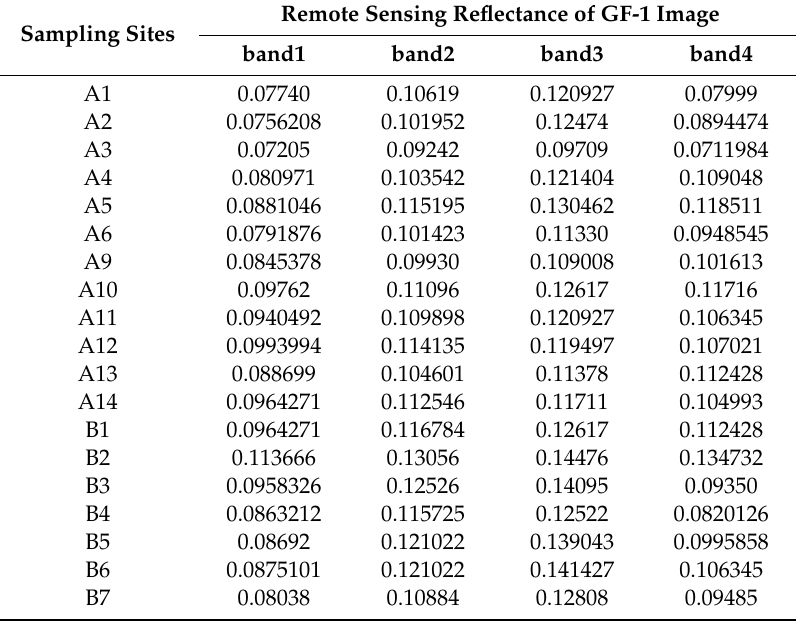
Table A2. The remote sensing reflectance of GF-1 image corresponding to sampling sites. Sampling